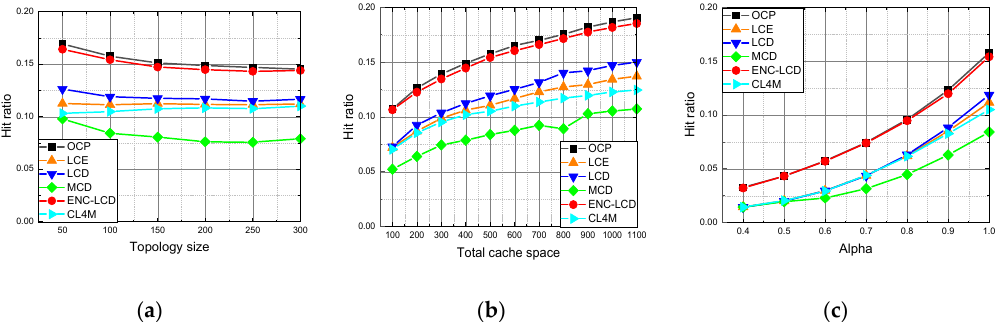
Figure 10. Performance of cache hit ratio in content placement. (a)The cache hit ratio under different